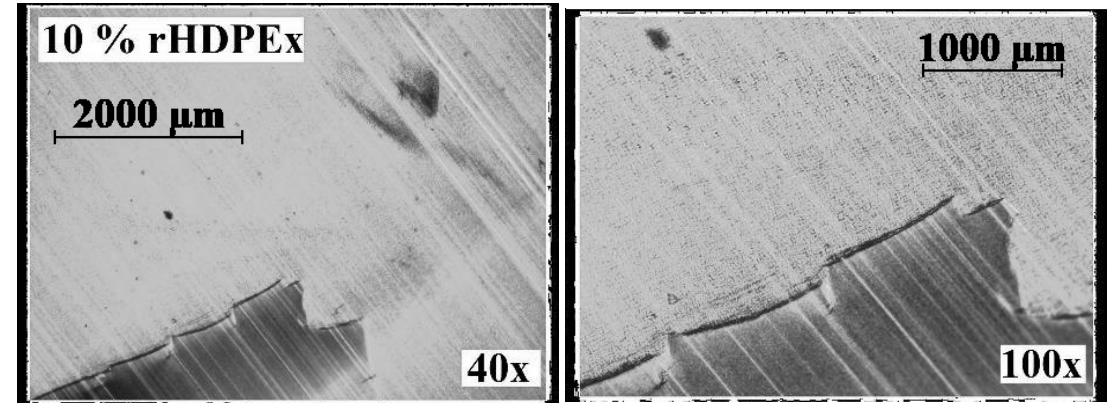
Figure 18. Microtome cuts of Mixture A.